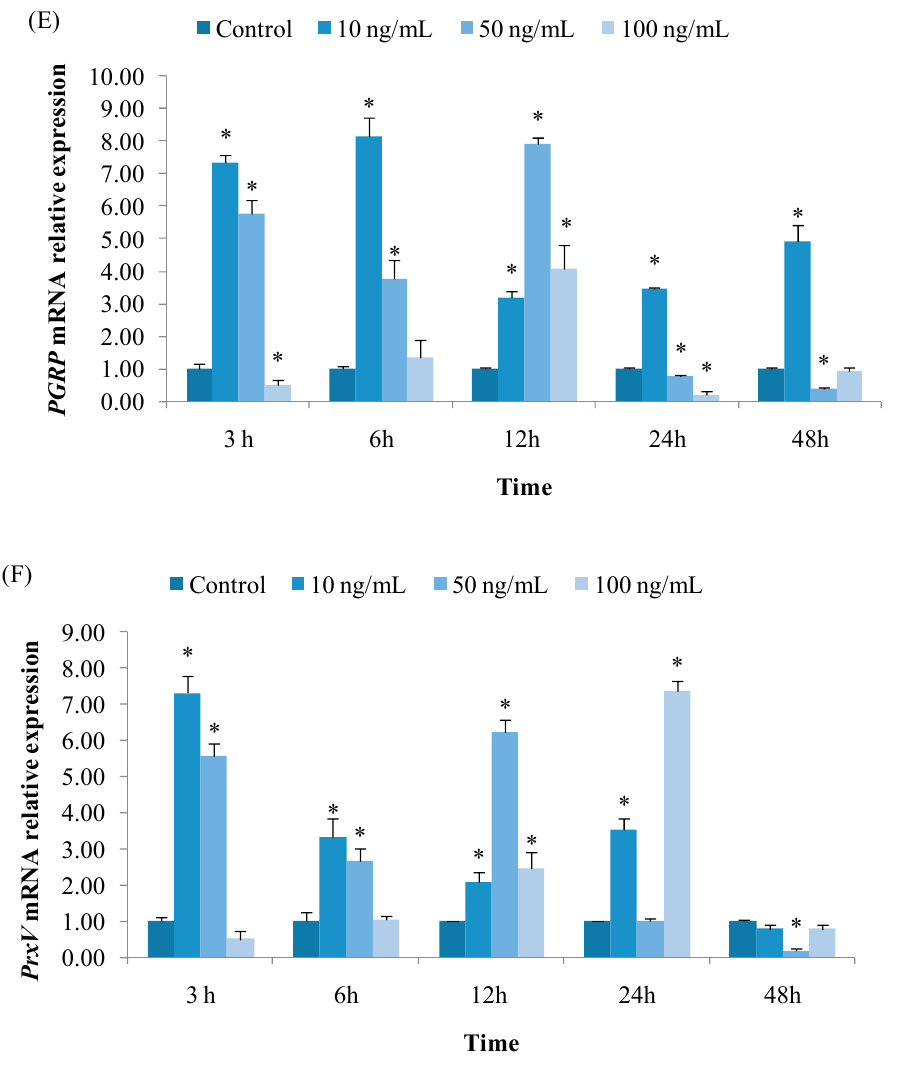
Figure 2. Effects of domoic acid (DA) on non-specific immune responses of the bay scallop Argopecten irradians at different time intervals after exposure to DA at three concentrations (10, 50, and 100 ng/mL). ( A ) CLT6 ; ( B ) FREP; ( C ) HSP90 ; ( D ) MT; ( E ) PGRP; ( F ) PrxV . Data represent mean ± SD values ( n = 3) at the same sampling time with “*” denoting significant differences the treatments of each exposure time ( p < 0.05).